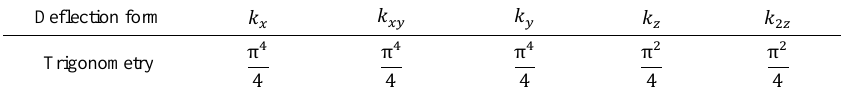
Table 1. Trigonometric form of stiffness coefficients of SSSS rectangular